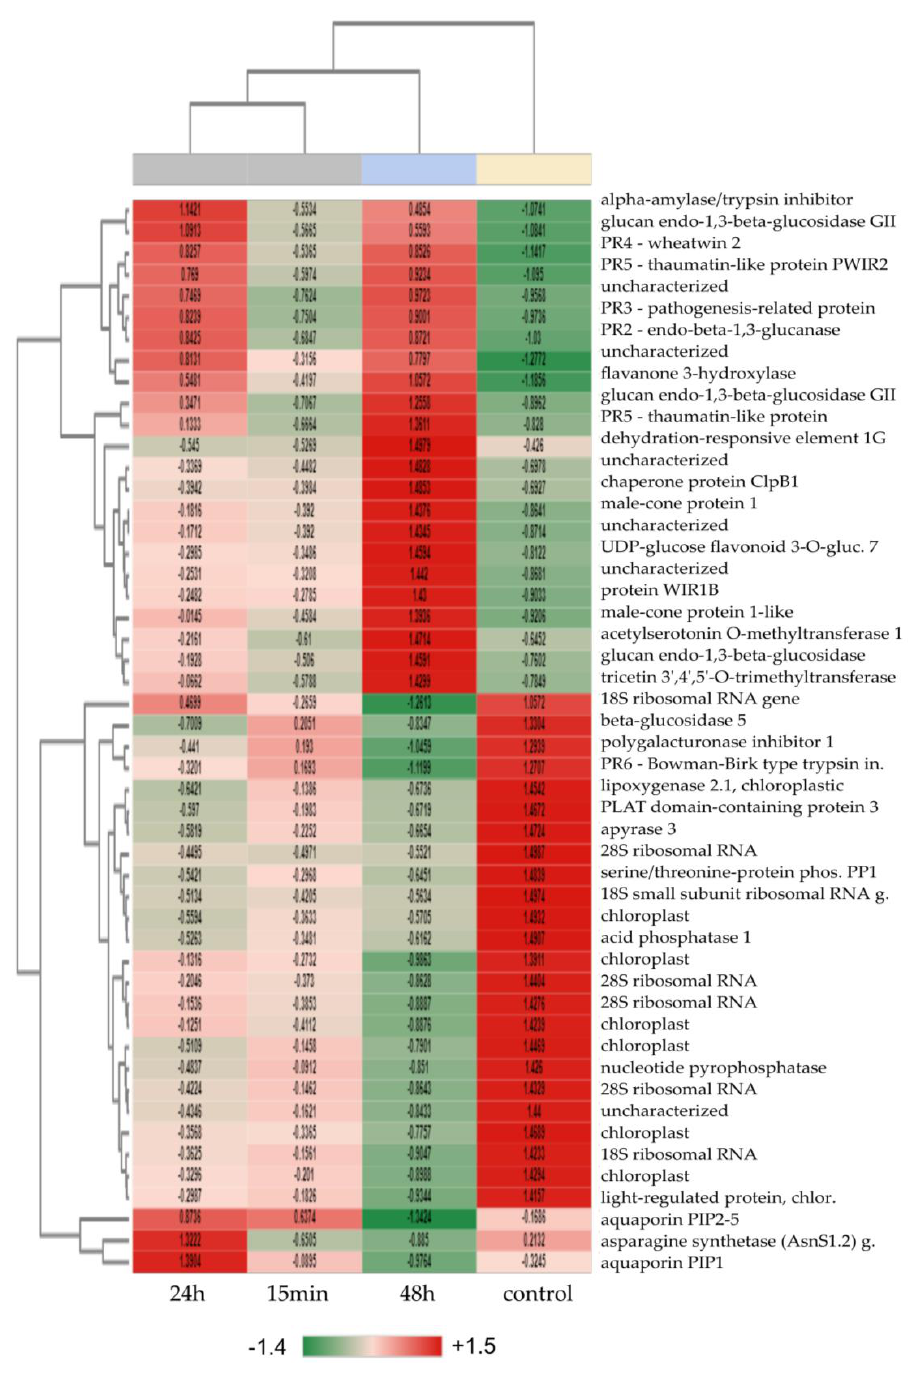
Figure 4. Heat map of the top 50 differentially expressed genes (DEGs) based on the comparison of the 48 h vs. control samples. The heatmap color range is from red for positive Z-score values to green for Z-score negative values. The number of differentially expressed (DE) features (Probability > 0.9): 2578. Up-regulated (M > 0): 865. Down-regulated (M < 0): 1713. For the annotation of the transcript IDs, see the Annotation Table (DOI: